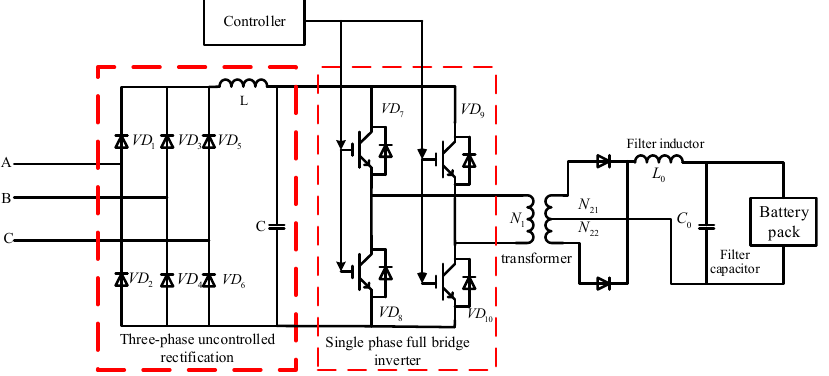
Figure 8. Basic topology of China Standard EMU charger.